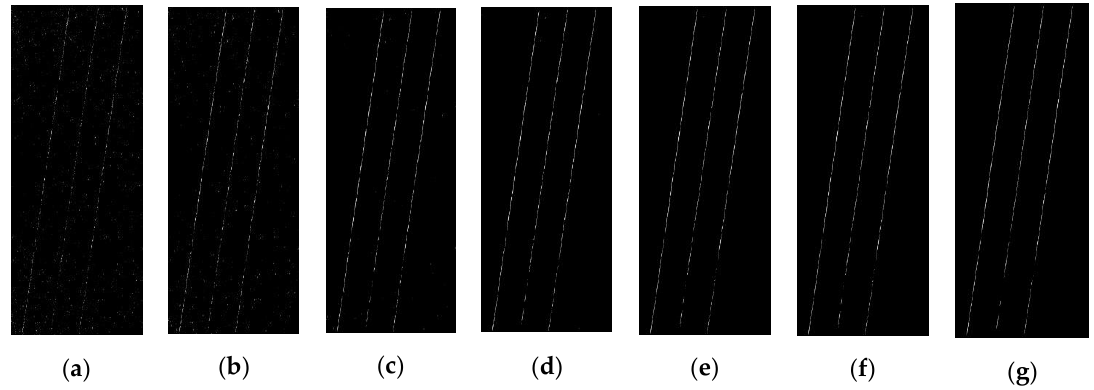
Figure A2. Results of filtration for filter sizes: ( a ) 5 pix., ( b ) 10 pix., ( c ) 20 pix., ( d ) 30 pix., ( e ) 40 pix., ( f ) 50 pix., ( g ) 60 pix.